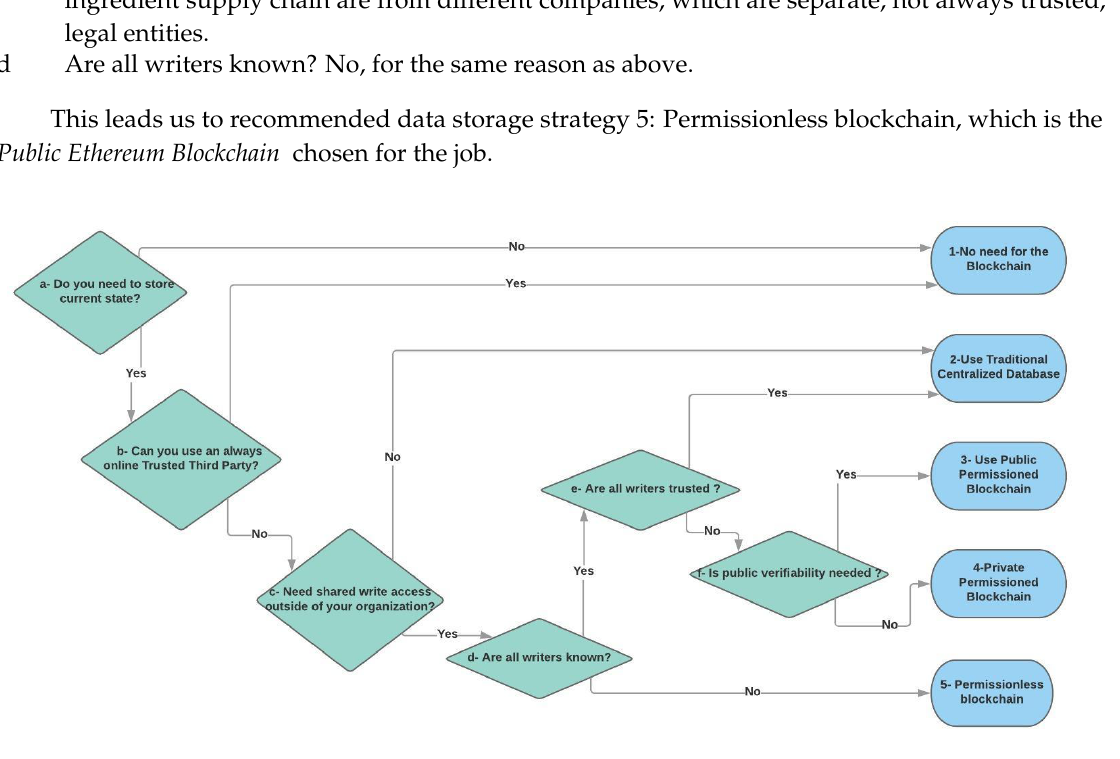
Figure 3. Defining if and what type of blockchain is the right choice for the problem: